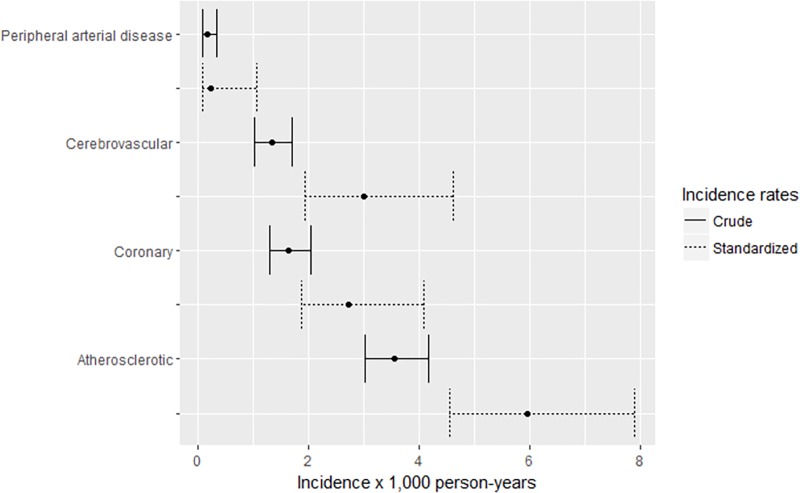
Crude and standardized incidence rates of vascular events per 1,000 person-years by event category, 2004–2015.